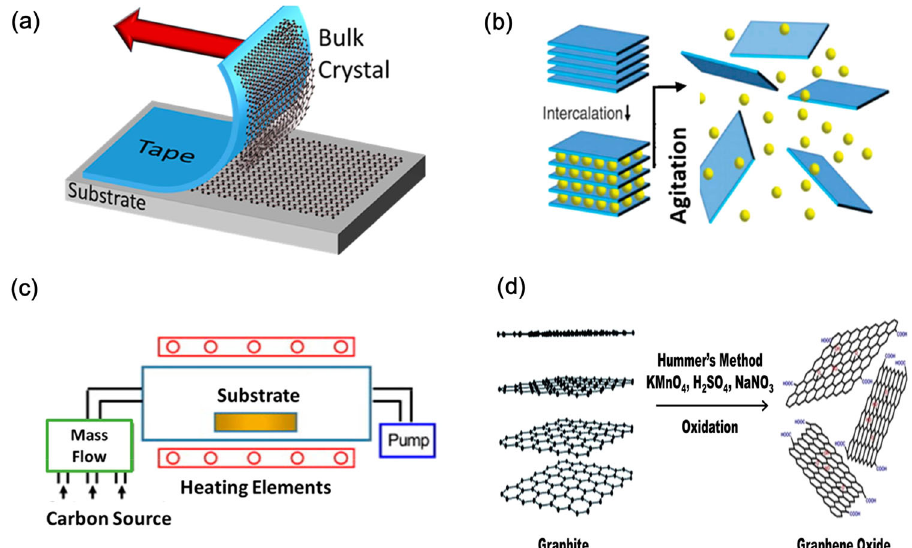
Fig. 5 Synthesis of graphene oxide. Some commonly used methods for the synthesis of GO. a Mechanical exfoliation “ Scotch Tape ” method. b Liquid exfoliation. c Chemical vapor deposition (CVD). d Hummers method. a – c is reproduced with permission from ref. 45 , Copyright 2019, American Chemical Society.